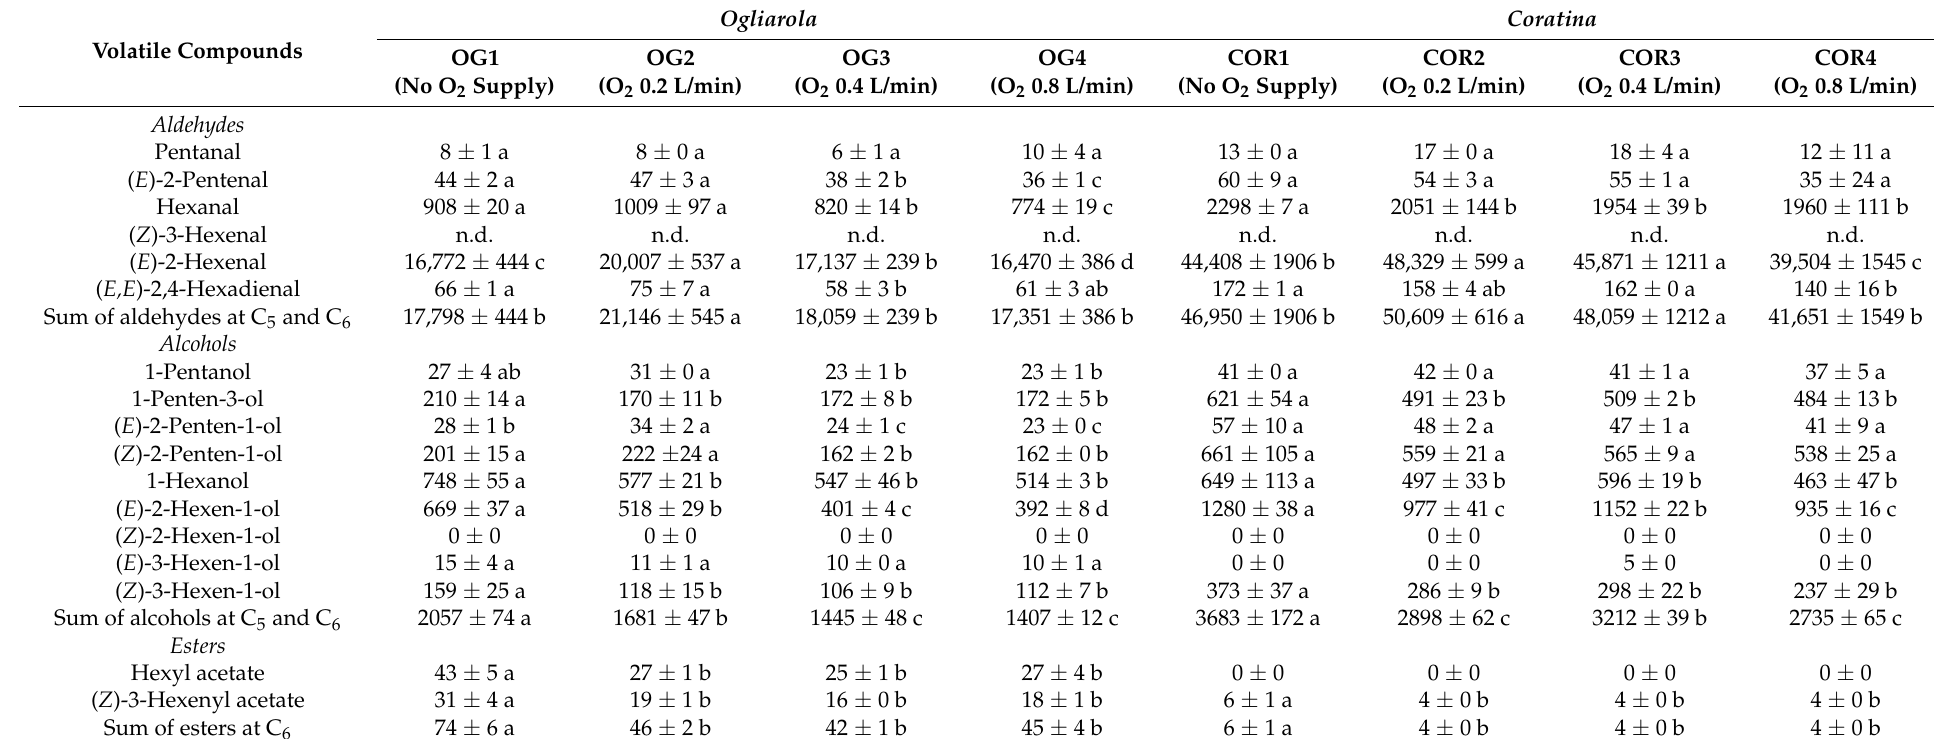
Table 3. Volatile composition ( µ g/kg) of VOOs extracted with different values of oxygen flow during the crushing